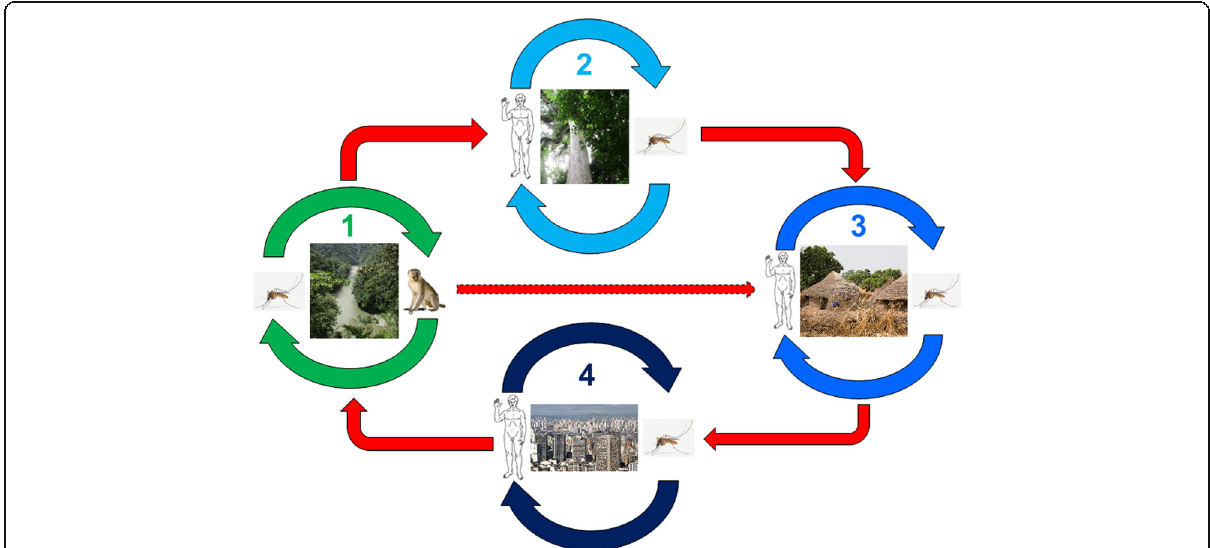
Fig. 5 Natural and epidemic cycles of yellow fever: 1=natural sylvatic cycle; 2=anthropogenic sylvatic cycle (plantation or deforestation); 3=village epidemic; 4=peri-urban or urban epidemic (1 to 4 in Africa, 1 and 4 only in South America) (adapted from [58,